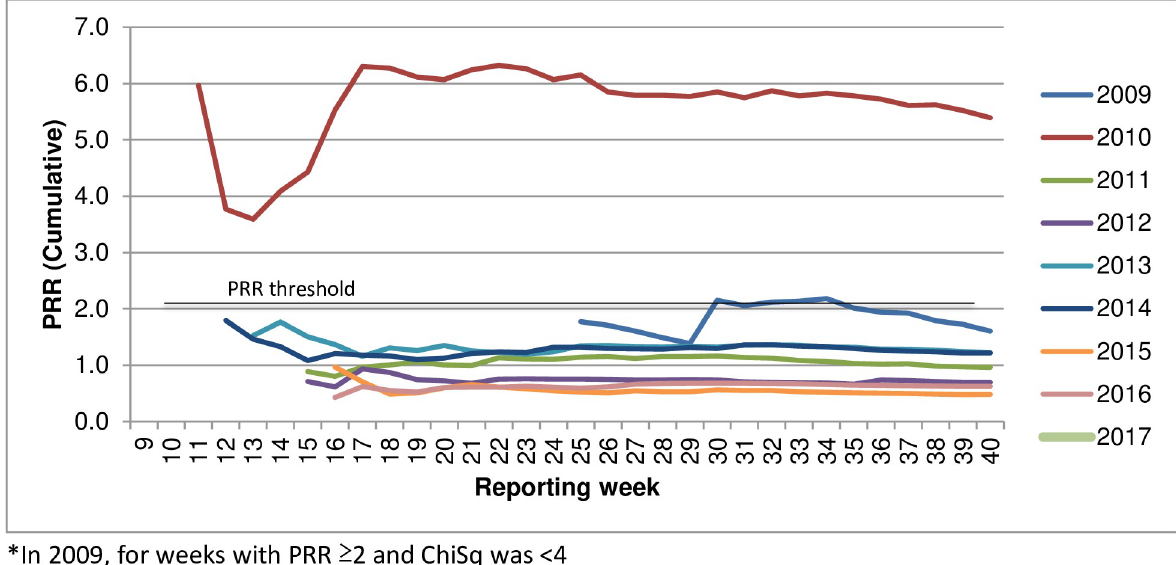
Fig 3. PRR cumulative (all previous years) for influenza vaccines & fever, by